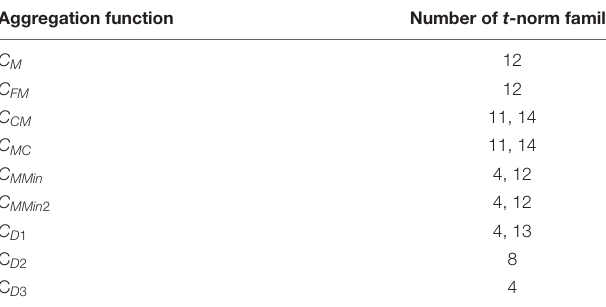
TABLE 2 | Triangular norms and their parameters for the results. Aggregation function Number of t -norm family